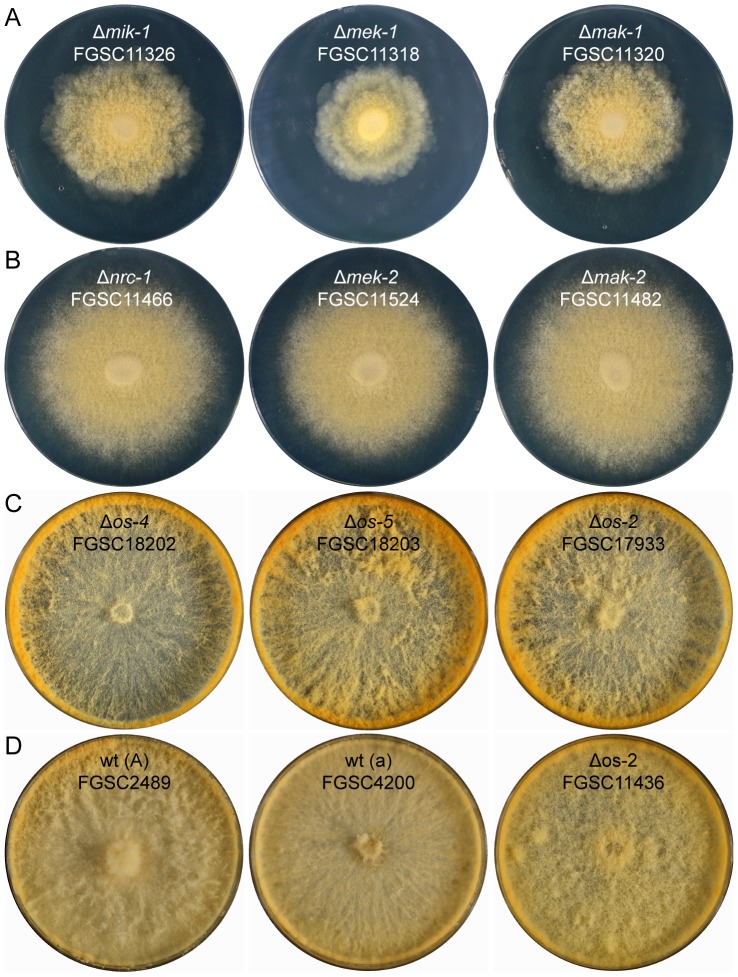
Colony morphology of MAP kinase mutants.All MAP kinase mutants showed macroscopic colony phenotypes clearly distinct from the wild type and between the three MAP kinase pathways, but highly conserved within each cascade. (A) CWI-MAP kinase mutants (Δmik-1, Δmek-1 and Δmak-1) typically showed increased autolysis resulting in rosette-like colony growth, and slow colony extension even on nutrient rich media. (B) MAP kinase mutants of the PR pathway (Δnrc-1, Δmek-2 and Δmak-2) were characterized by short aerial hyphae and conidiation starting from the colony center. (C) Colony phenotypes of OS-MAP kinase mutants (Δos-4, Δos-5 and Δos-2) comprised reduced aerial hyphae in the colony center, elevated carotenoid biosynthesis and intense production of ‘sticky’ aerial hyphae and macroconidiophores were foremost at the plate edge. (D) Wild type controls, and the ‘old’ Δos-2 strain FGSC11436, which displayed a colony phenotype different to that of the genuine os mutants (see Figure S4 for a more detailed genotypic and phenotypic comparison between the two Δos-2 mutants FGSC11436 and FGSC17933).